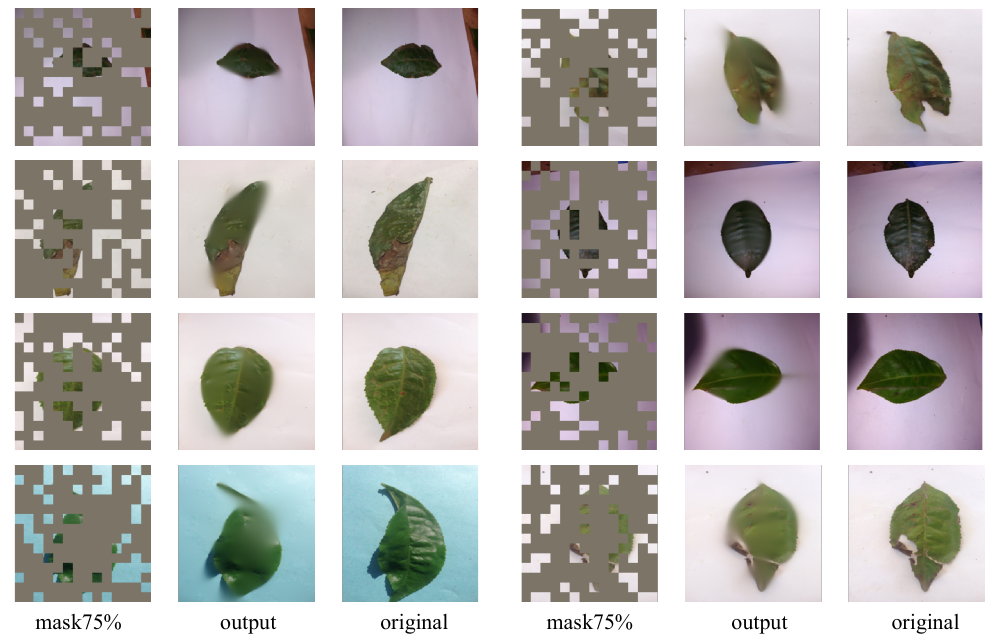
Figure 7. Completion results of the tea disease images.